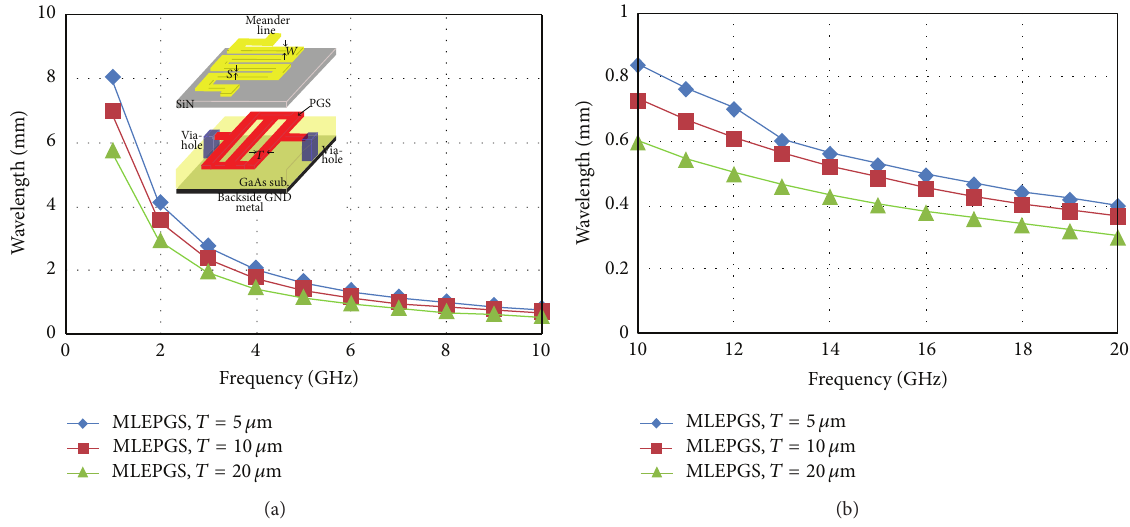
Figure 1: (a) Measured wavelength of the MLEPGS with various 𝑇 in a frequency range of 1 ∼ 10GHz and (b) 10 ∼ 20GHz.